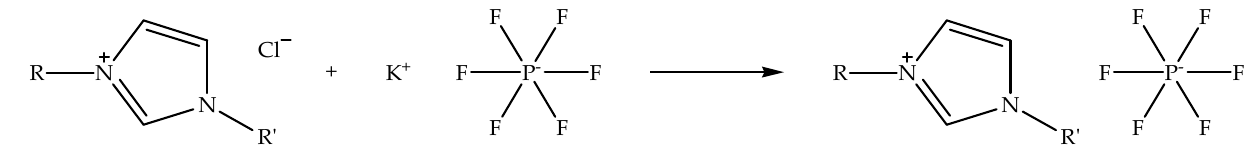
Figure 3. Schematic of the metathesis reaction of alkylimidazolium chloride with potassium hexafluorophosphate to prepare alkylimidazolium hexafluorophosphate ionic liquid.